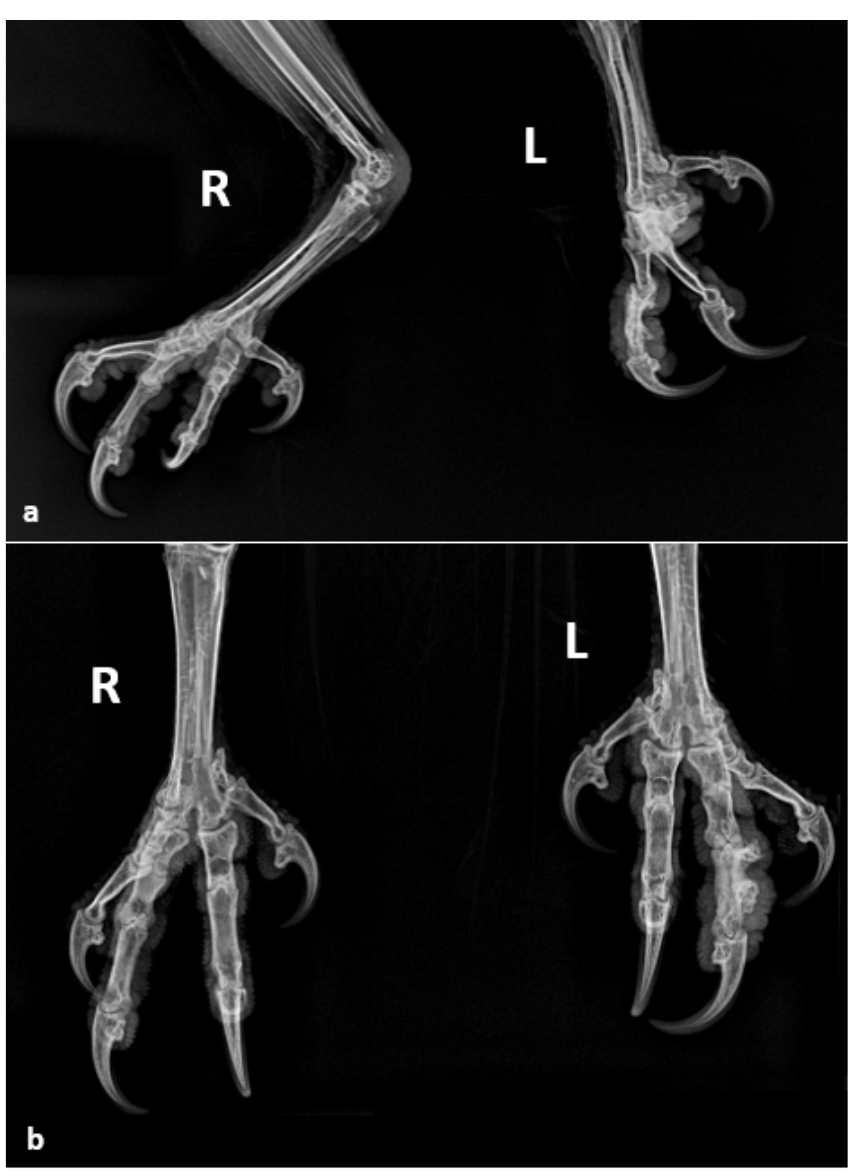
Figure 3. Verreaux’s eagle owl feet six weeks post-treatment. Lateral ( a ) and DP ( b ) follow-up radiographs taken six weeks post-removal of the cable tie.